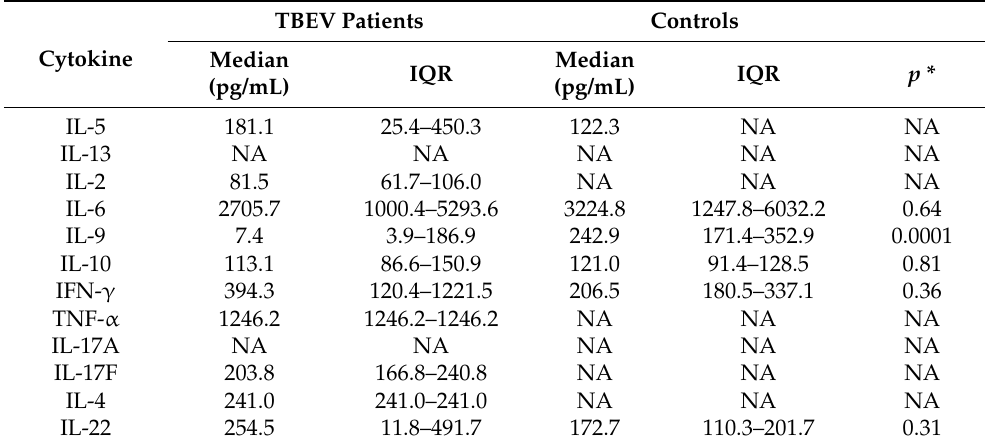
Concentrations of cytokines in the CSF of TBEV patients and controls are presented in Table 4. Concentrations of IL-6 (the most abundant cytokine in the CSF of both groups), IL-10 and IL-9 were lower in TBEV patients compared with controls, but the difference was statistically significant for IL-9 only ( p = 0.001). Concentrations of IL-5, IFN- γ and IL-22 were higher in the TBEV group compared with controls. Th2 cytokine IL-13, as well as IL-17A, were undetectable in the CSF. Several cytokines, including IL-2, TNF- α , IL-17F and IL-4, were detectable in the CSF of a small proportion of TBEV patients only (1–3 patients for each cytokine). Table 4. Cytokine levels in CSF of TBEV patients and controls. TBEV Patients Cytokine